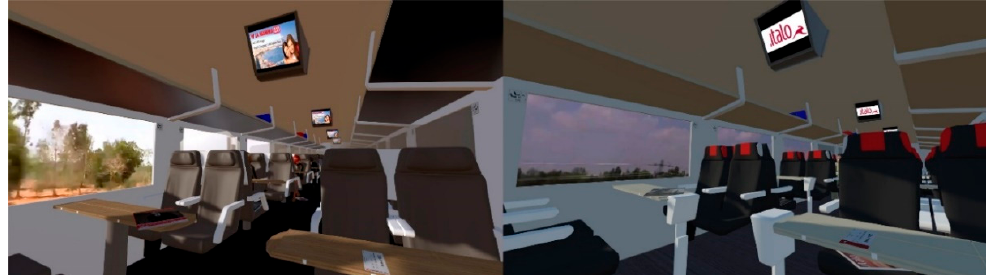
Figure 4. Interior of the “Frecciarossa” (left side) and “Italo” (right side) high-speed virtual trains.